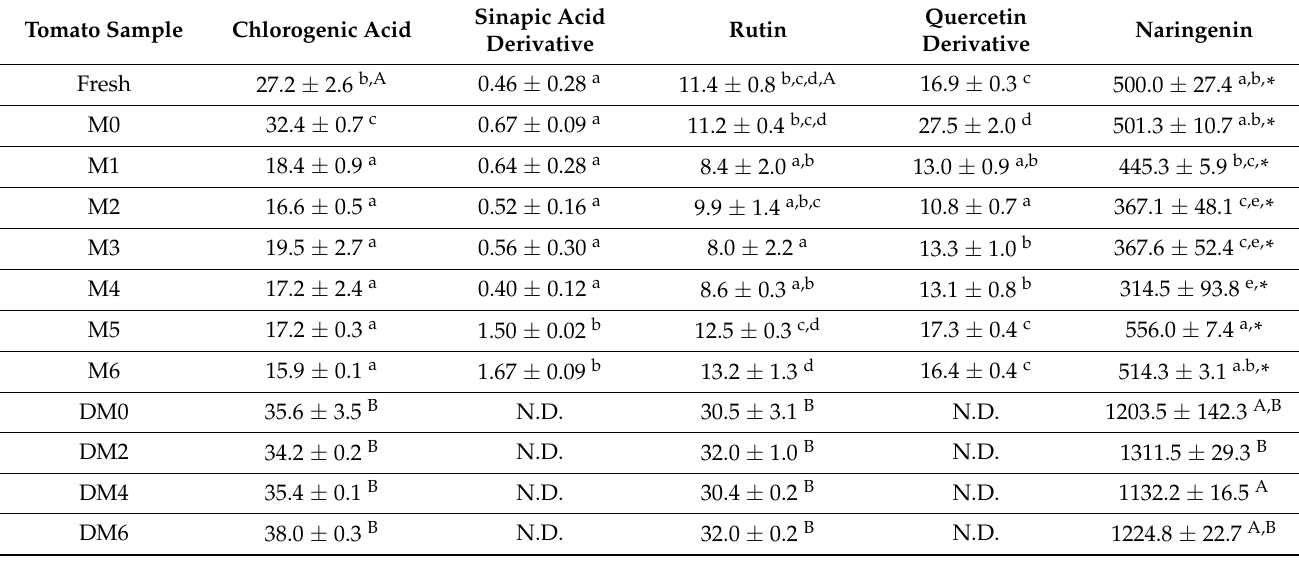
Table 3. Identification and quantification of phenolic compounds ( n = 4) present in fresh tomato by-products and during Table 280. 320 and 350 nm. All results (mean ± standard deviation) were expressed in mg 100 g − 1 on a dry basis. Tomato